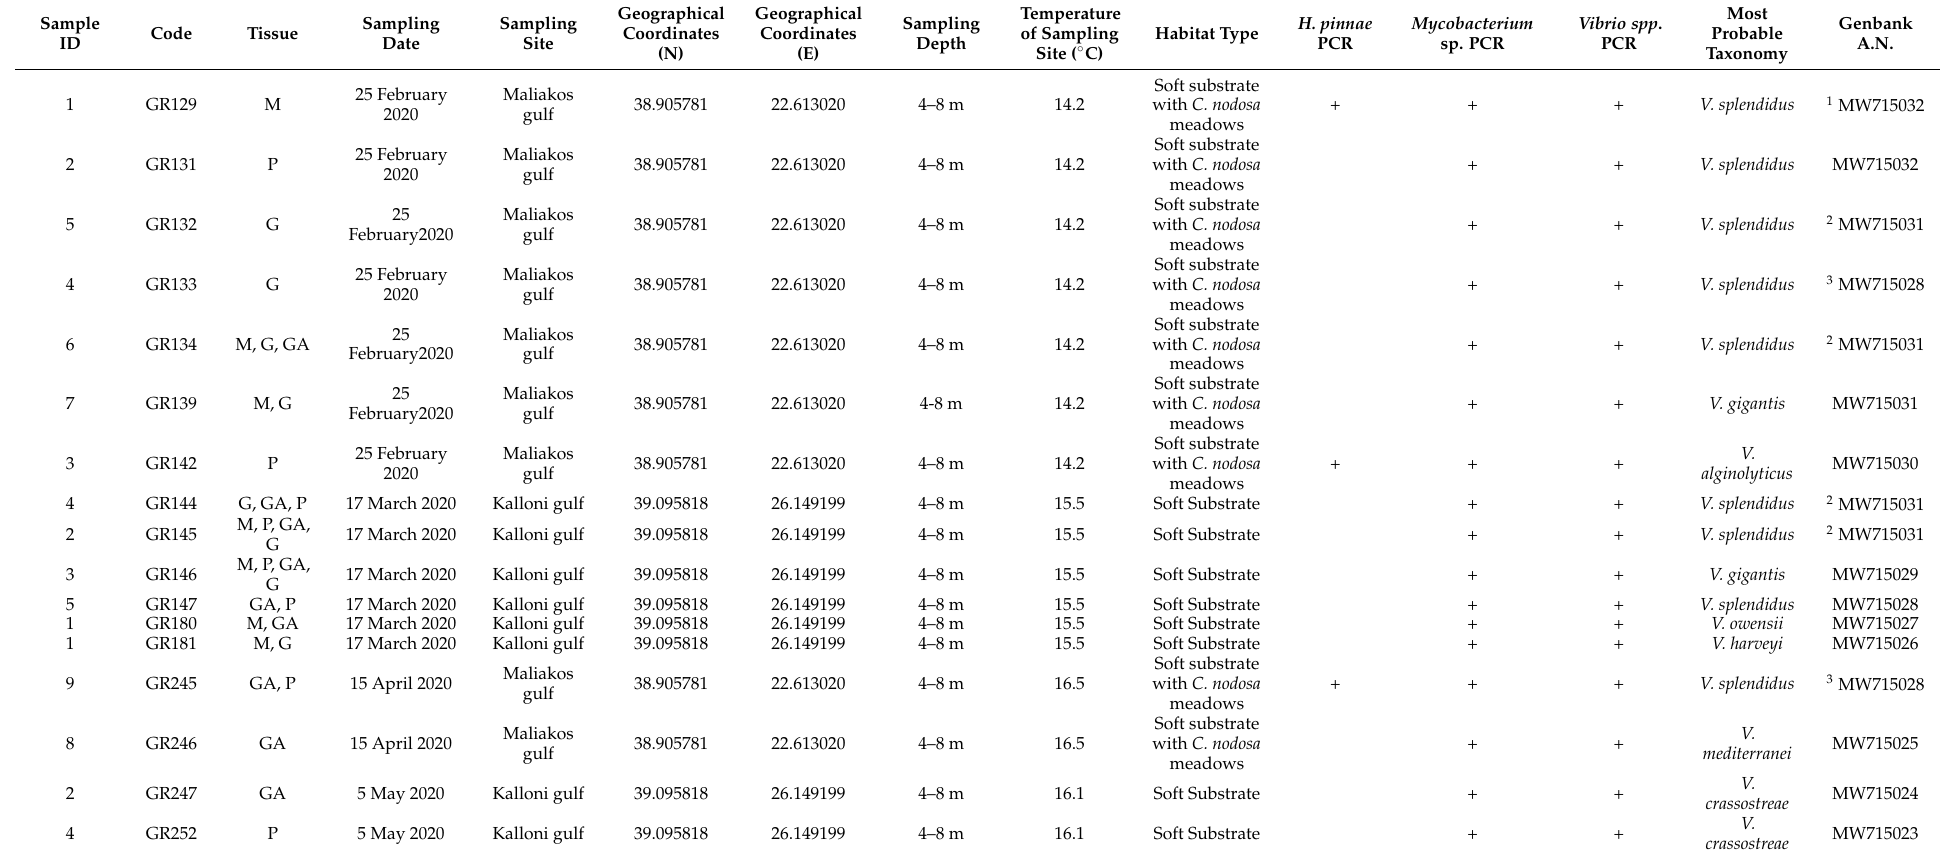
Table 1. Sampling data of the animals analyzed and the results of microbiological analysis in animal tissues. M, P, G, and GA are the abbreviations for mantle tissue, posterior adductor muscle, gill tissue, and digestive gland,